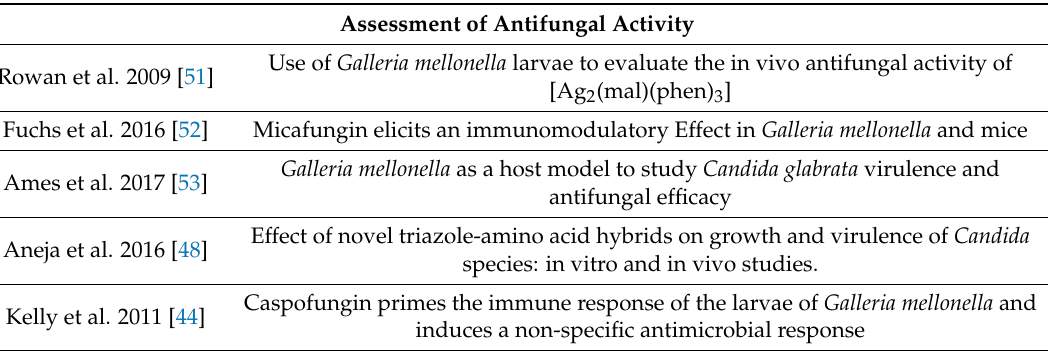
Table 2. Examples of use of G. mellonella larvae with antifungal